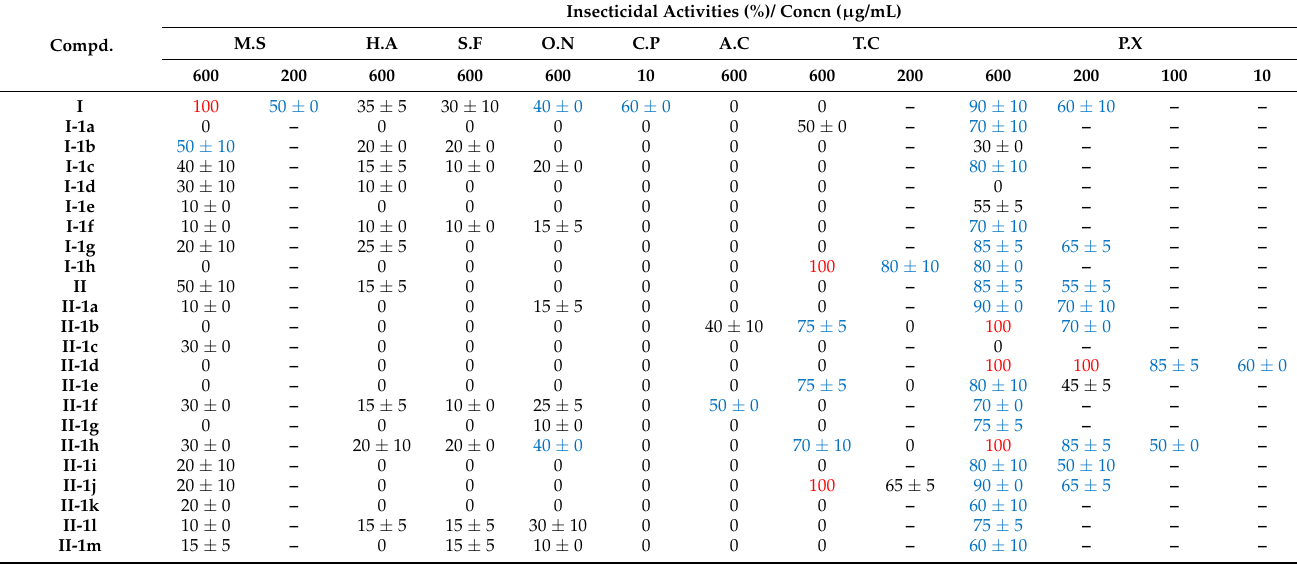
Table 4. Insecticidal activities of compounds I , II , III , I-1a – I-1h , II-1a – II-1m , III-1a – III-1f , matrine, hexaflumuron and rotenone against eight common crop pests a